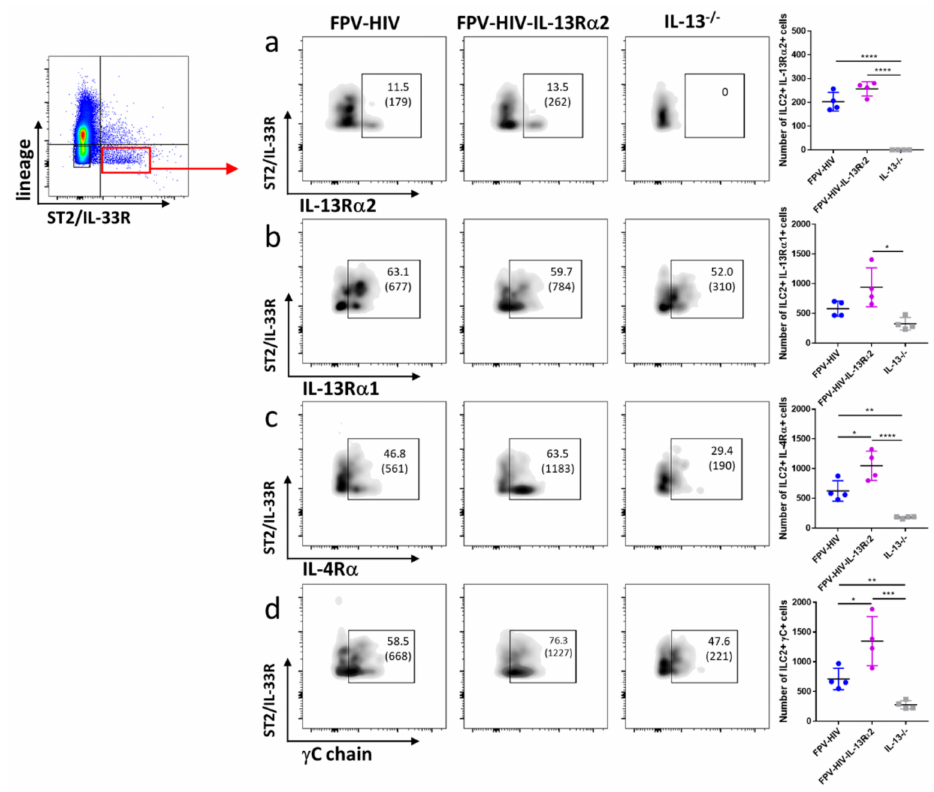
Figure 4. Evaluation of lung lineage − IL-33R/ST2 + ILC2 expressing IL-13R α 2, IL-13R α 1, IL-4R α , and γ C following vaccination under permanent vs. transient inhibition of IL-13. WT BALB/c and IL-13 − / − mice on BALB/c background (n = 4) were immunized intranasally with FPV-HIV-IL-13R α 2 adjuvanted or FPV-HIV unadjuvanted vaccines. Color coded vaccine groups represent: blue, WT BALB/c given FPV-HIV (control); purple, WT BALB/c given FPV-HIV-IL-13 α 2 adjuvanted vaccine (which represents transient IL-13 sequestration/inhibition condition); and grey, IL-13 − / − given FPV-HIV (which represents permanent IL-13 inhibition condition). Lung ILC2 were gated as CD45 + FSC low SSC low lineage − IL-33R/ST2 + cells. The FACS plots in each panel indicate the percentage of ILC2s expressing IL-13R α 2 ( a ), IL-13R α 1 ( b ), IL-4R α ( c ), and γ C chain ( d ). The bracket below the cell percentage indicates the number of cells in each gate. The graph in each panel represents the number of ILC2s expressing the different receptors back calculated to CD45 + population, as described in the materials and methods (24 h post vaccination). The error bars represent the mean and standard deviation (s.d.). The p values were calculated using one-way ANOVA using Tukey’s multiple comparisons test and unpaired t -test. * p < 0.05, ** p < 0.01, *** p < 0.001, **** p < 0.0001. Experiments were repeated a minimum of 3